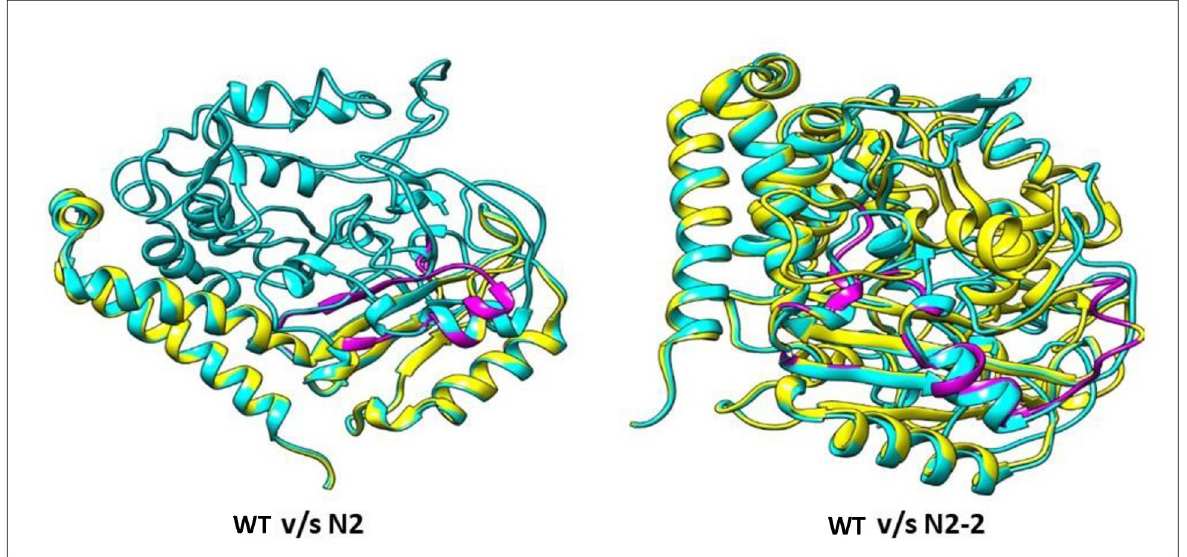
Fig 4. Ribbon representations of Trichoderma N2, N2-2 and WT strain tub2 protein. Deduced amino acids structural superimposition between N2 and N2-2 with WT of tub2 gene differ by 37 and 183 mutant residues. In both the images—yellow (mutant protein), cyan (WT protein) and magenta (mutant